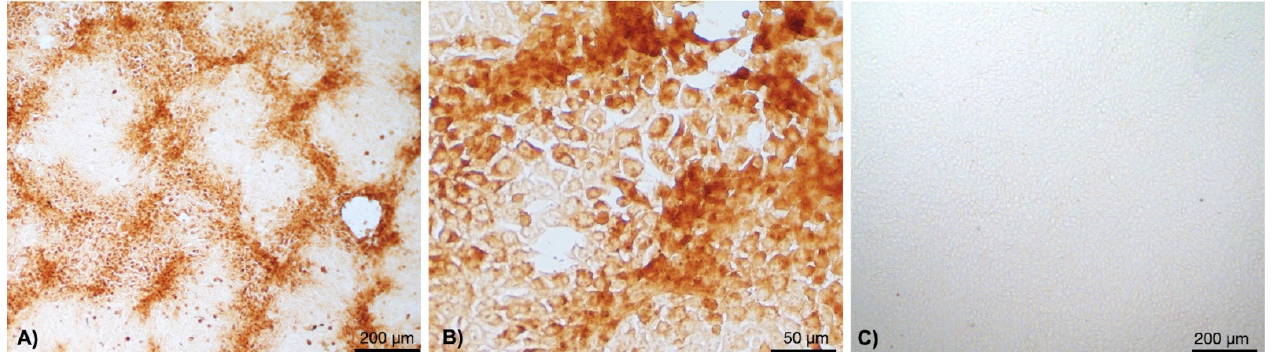
Table 1. Results of p32 real-time PCR for skin and blood samples collected from 111 animals. Figure 3. Number of reported LSD-affected provinces and cases during the first epidemics in Thailand. ( A ) The bar chart shows the numbers of LSD-affected provinces from March 2021 to June 2022 in each geographical region of Thailand. ( B ) The epidemic curve of new LSD cases from March to July 2021. Data were retrieved from E-smart surveillance (DLD, 30 June 2022).